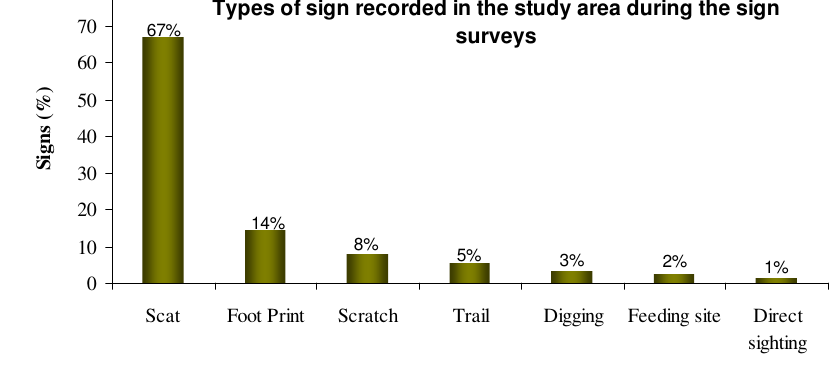
Fig. 2. Types of sloth bear sign recorded in the study area during the sign